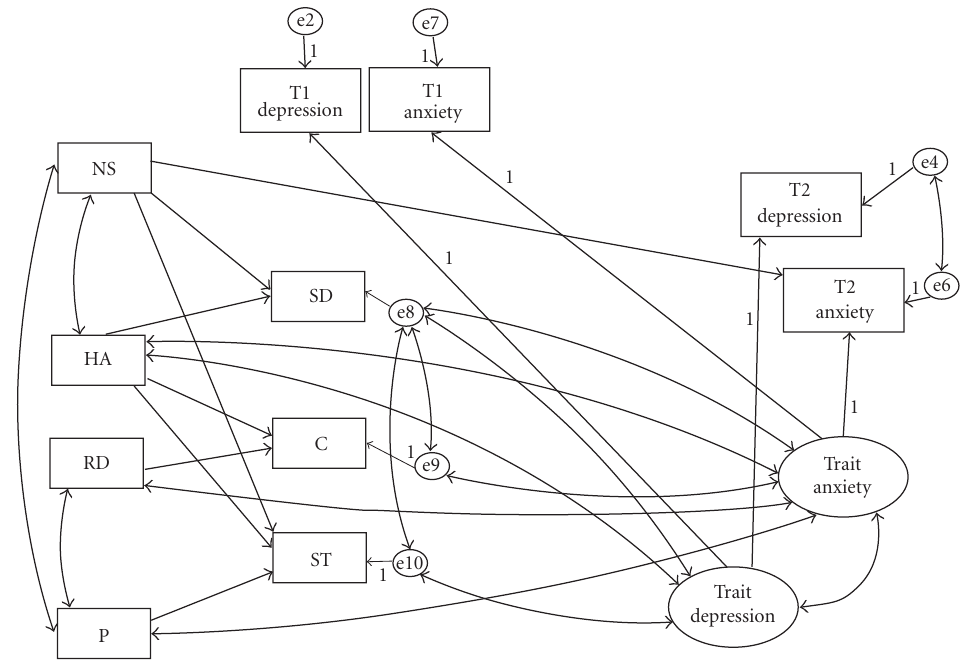
Figure 1: Structural regression path of the T1 HADS and T2 HADS dimensions and the TCI subscales. NS: novelty seeking; Ham: harm avoidance; RD: reward dependence; P: persistence; SD: self-directedness; C: co-operativeness; ST: